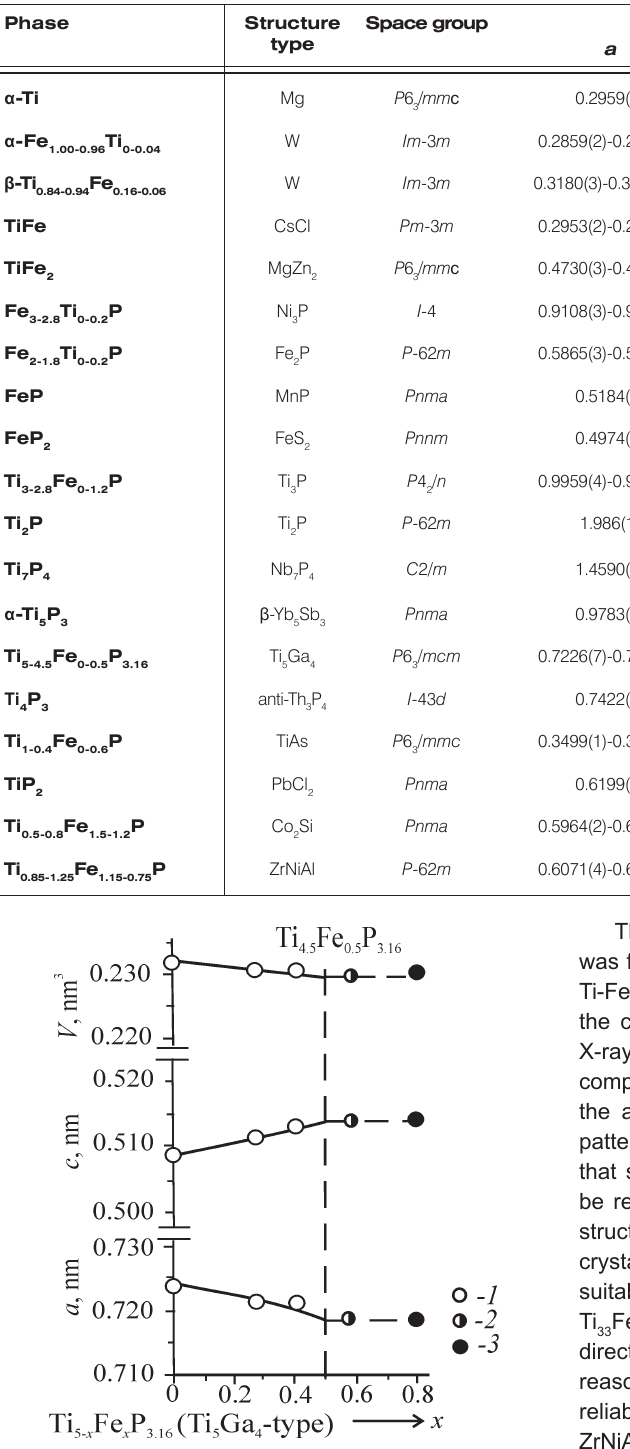
Figure 1. Dependence of the lattice parameters and the unit cell volume V of Ti Fe P solid solution vs. the 5-4.5 0-0.5 3.16 concentration of Fe (1 – single phase; 2 – two phases; 3 – three